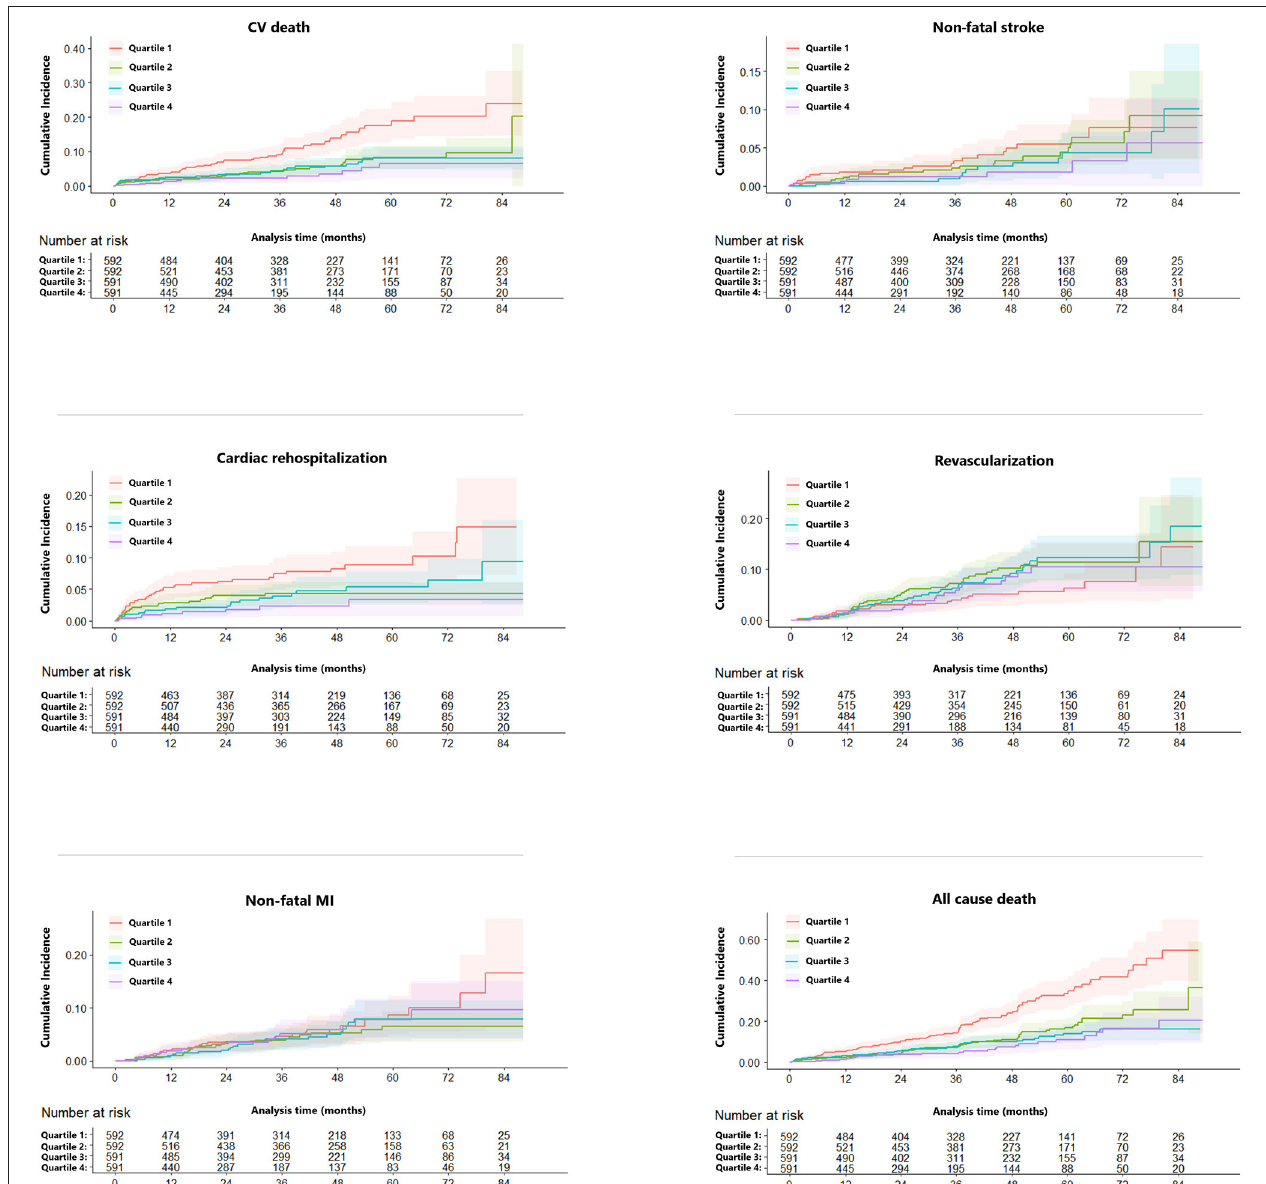
FIGURE 1 | Competing risk regression curves for CV death, non-fatal MI, non-fatal stroke, cardiac rehospitalization, and revascularization of the eGFR ≤ 63.02 (Quartile 1, red line), 63.03–78.45 (Quartile 2, green line), 78.46–91.50 (Quartile 3, blue line), > 91.51 (Quartile 4, purple line) ml/min/1.73 m 2 . CV, cardiovascular; MI, myocardial infarction; eGFR, estimated glomerular filtration